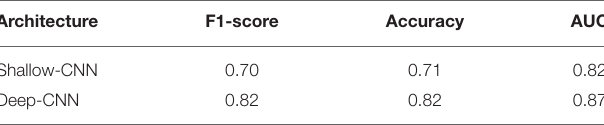
TABLE 4 | Performance of CNN architectures fine-tuned on the NMT dataset after training on the TUH dataset.